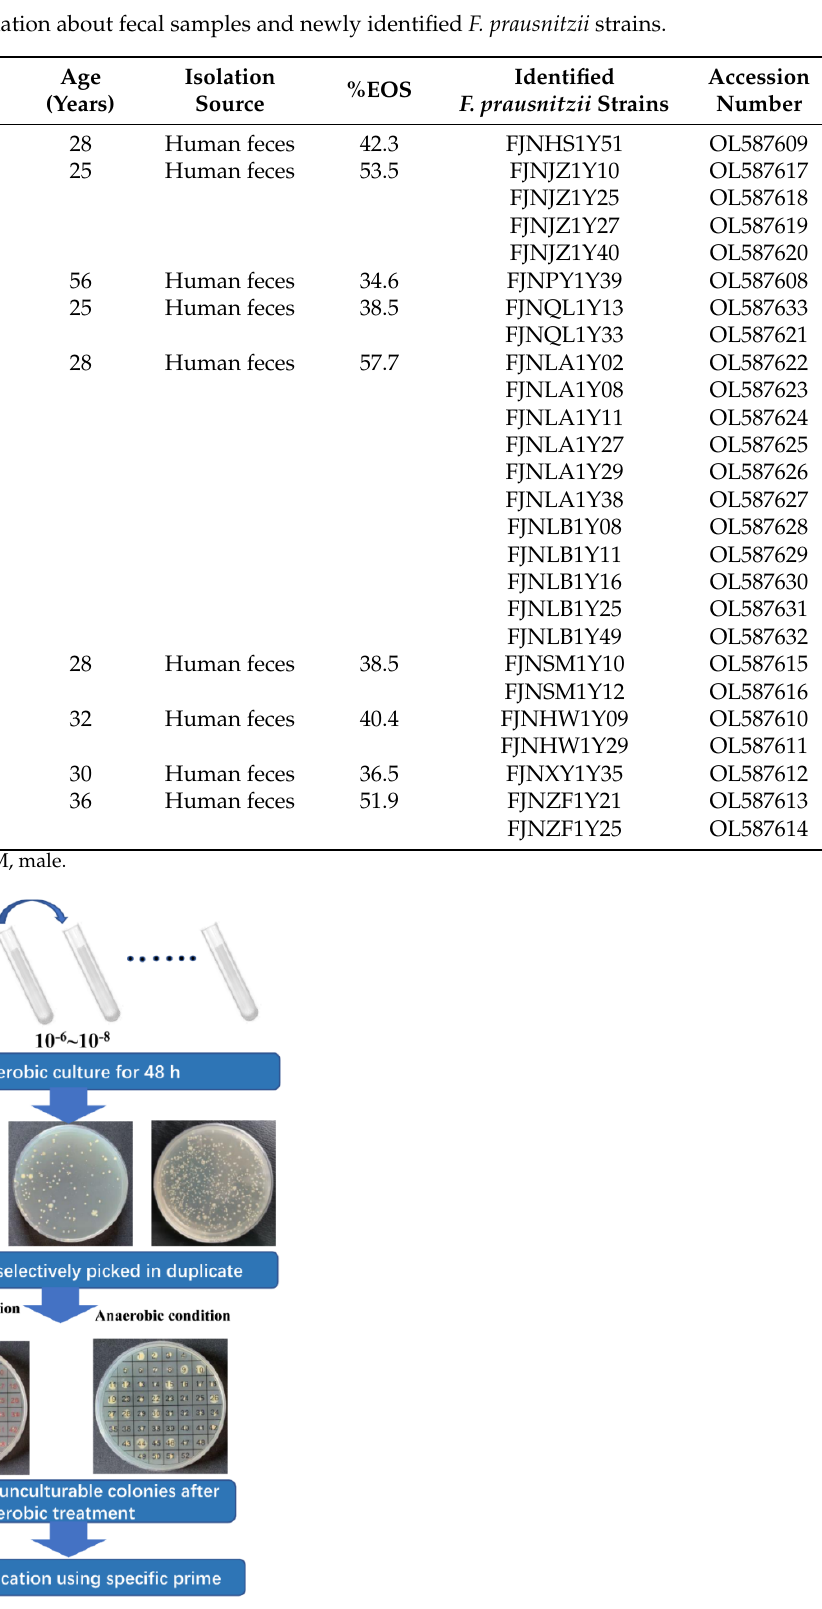
Figure 1. Combination of negative screening and prime-specific PCR amplification (NSPA) for isolation of F. prausnitzii strains from healthy human feces.